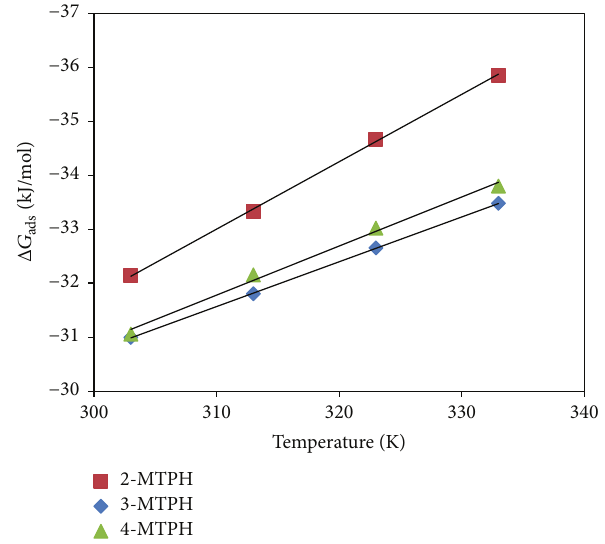
Figure 5: Plot of Δ𝐺 ads versus 𝑇 for 2-MTPH, 3-MTPH, and